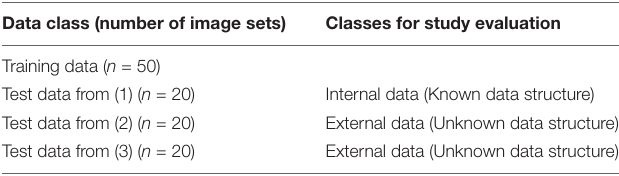
TABLE 1 | Data from center 1 was acquired on the same hardware as training data and thus considered to be of known structure (= internal